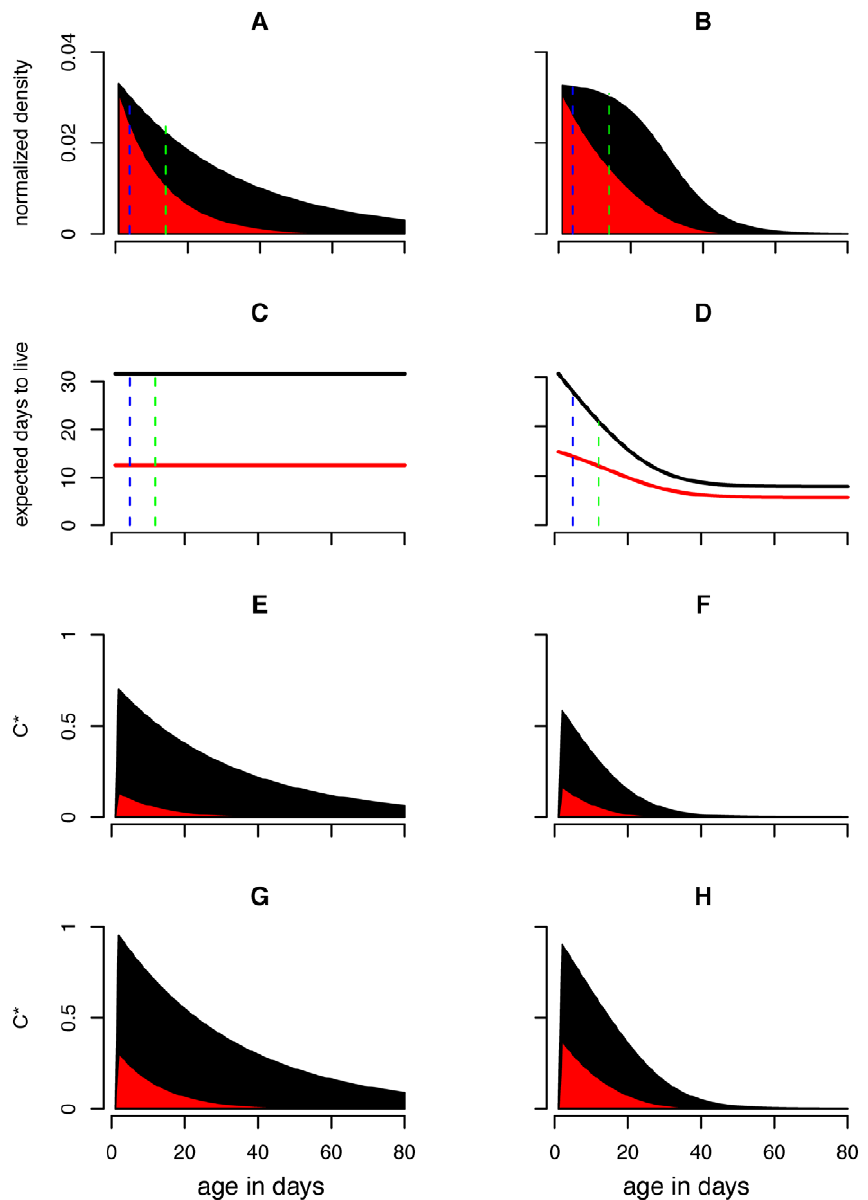
Figure 3. Effects of reduced mosquito survival on demography and vectorial capacity. The above figure displays the effects of reducing mosquito survival ( r A =0.05, red) compared to a baseline scenario ( r A =0, black) on the mosquito population distribution (A,B), the life expectancy function (C,D) and the C* contributions by age class for extrinsic incubation periods of 12 days (E,F) and 2 days (G,H). The left column of panels (A,C,E,G) displays results from the constant mortality model while the right column of panels (B,D, F, H) show results from the age dependent mortality model. The proportional reduction in C* due to reducing survival is greater for the constant model than for the age dependent model, and greater for the longer EIP. The green and blue dashed lines in the first two rows indicate the youngest age at which mosquitoes can be infectious when the EIP is 2 and 12 days, respectively. Because C* can be calculated by summing across ages old enough to be infectious the product of mosquito density and life expectancy (Equation 12), these dashed lines can be used to visually inspect how the first two rows of panels yield the second two. The region between the dashed lines in panels A and B consist of the mosquitoes who are too young to be infectious for an EIP of 12 days but are old enough to be infectious for an EIP of 2 days. While the proportional reduction of these age classes due to reducing mosquito survival is relatively small compared to older mosquitoes, the proportional reduction in life expectancy in these age classes is quite large. These effects almost balance each other out such that interventions that reduce mosquito survival are only slightly less efficient for shorter EIPs (see Figure 5). mosquito control. Models using an empirically derived age constant mortality models may have underestimated the effective- ness of anti-vectorial measures. dependent hazard predicted that about double the level of control will be needed to achieve the same proportional reduction in C* as Younger mosquitoes should contribute relatively more towards compared to constant hazard models (Figure 6). Consequently, disease transmission when EIPs are shorter because mosquitoes these results contradict Dawes et al. (2009)’s [41] suggestion that can be infectious at a younger age. Again, increases in r A reduce